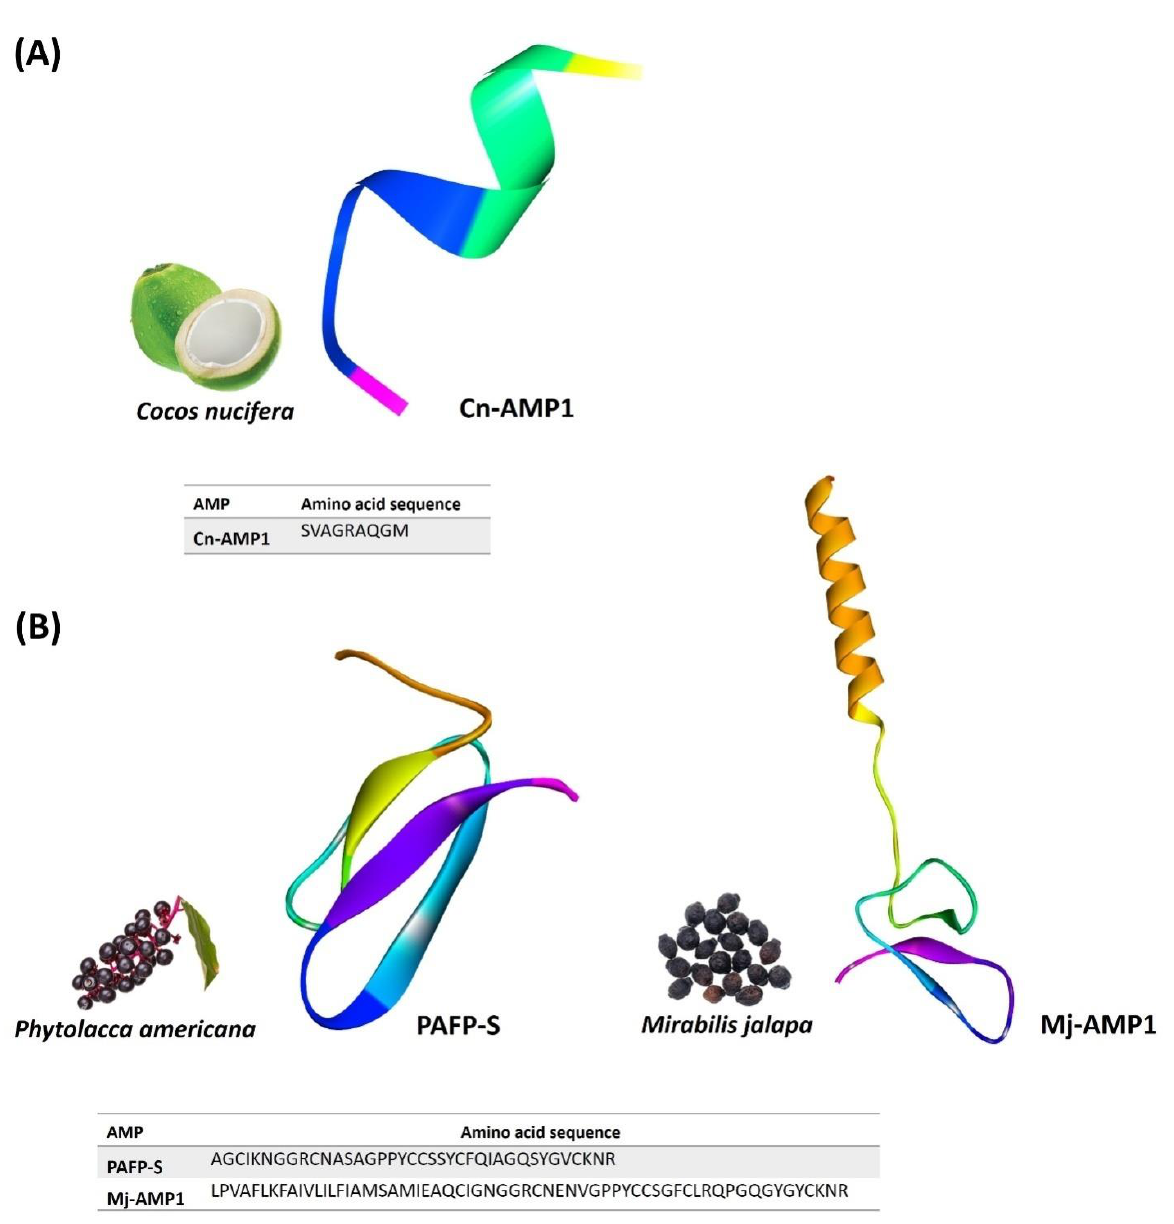
Figure 4. Selected napin ( A ) and knottin-like ( B ) plant AMPs that have potential antimicrobial activities for food preservation: Cn-AMP1 (PDB ID: 2N0V), PAFS-S (PDB ID: 1DKC), and Mj-AMP1 (predicted in this study). Predicted structures are modeled via homology modeling using the Swiss model (https://swissmodel.expasy.org accessed on 30 July 2022).